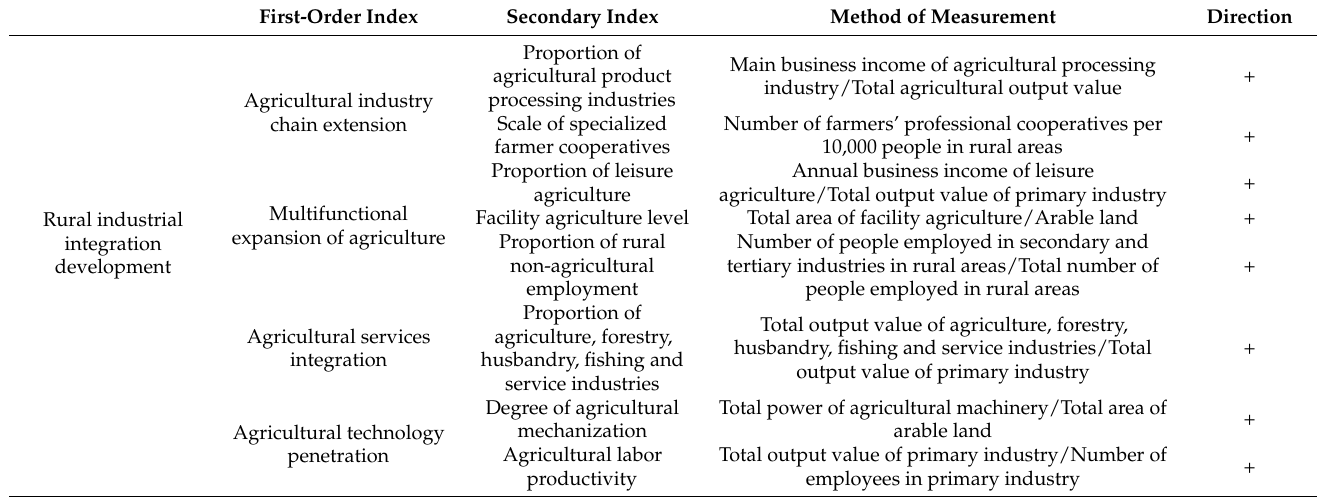
Table 2. Indicator system of integration of three rural